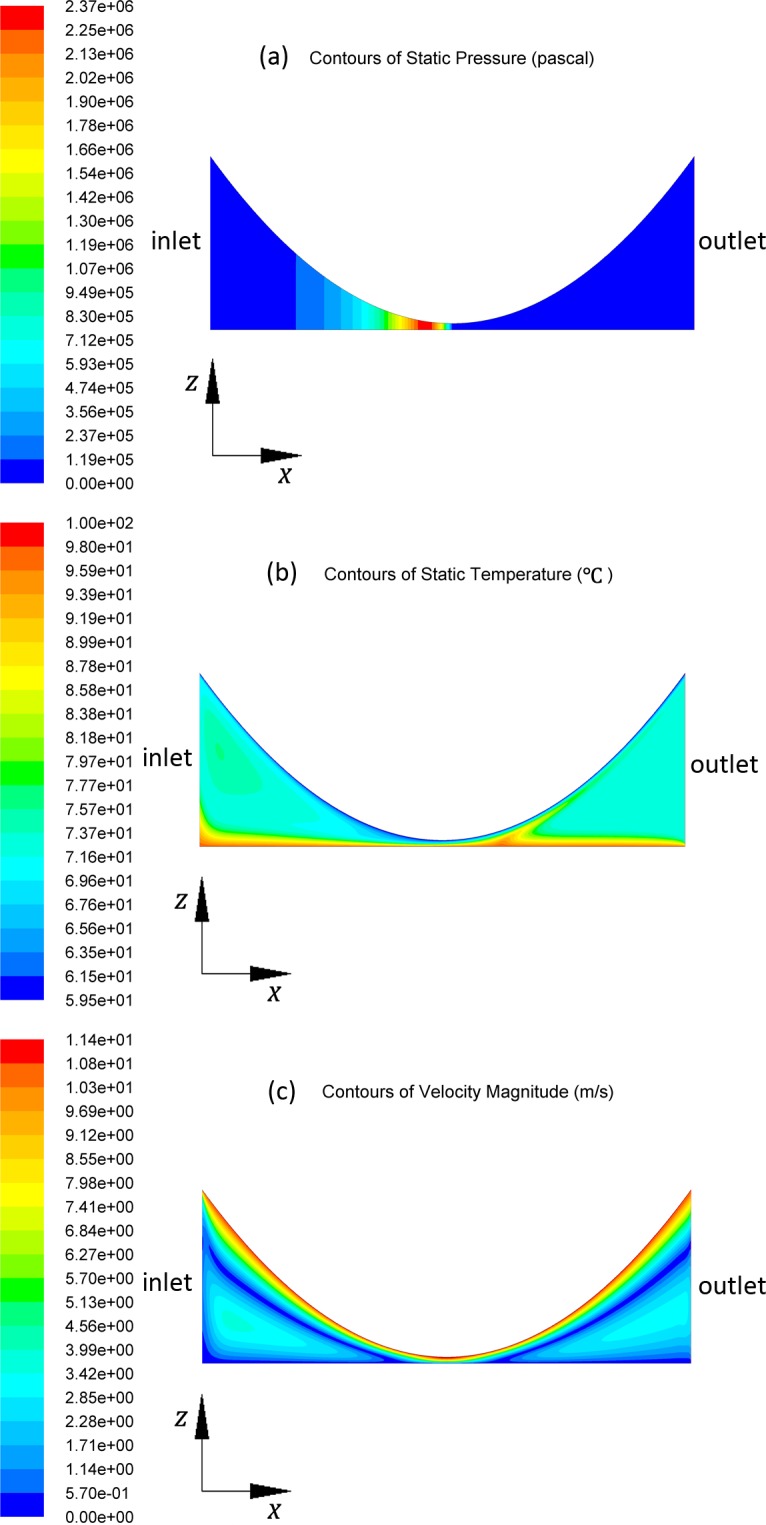
Contours of pressure, temperature and velocity distribution.